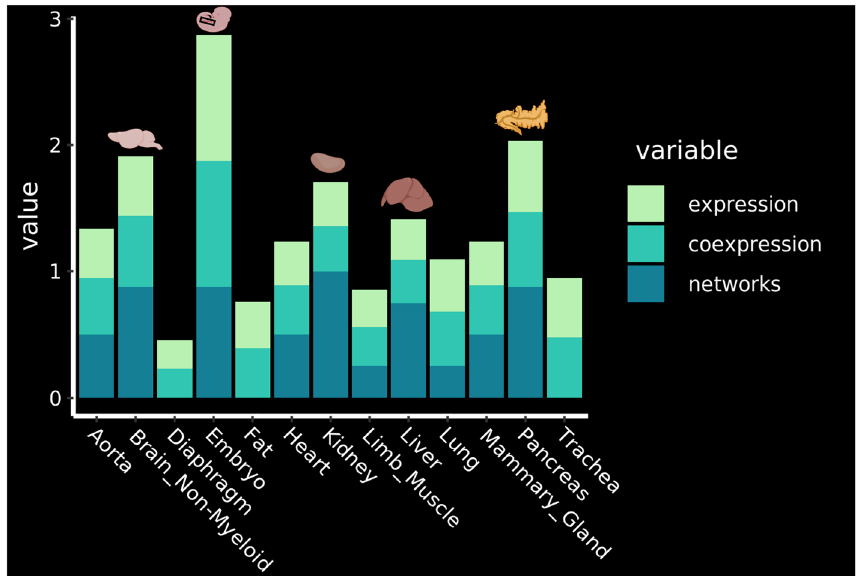
Figure 7. Identification of the most promising tissues for reprogramming. Ranking of the tissues according to the expression of the key transcription factors, their co-expression and the results of the network analysis. The top 4 organs are highlighted with their corresponding drawing. See methods for details about how the ranking was established. Figure was made in BioRender—https:// biore nder.